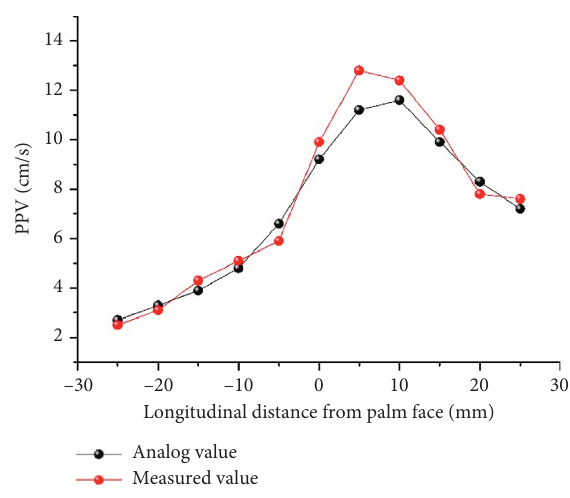
Figure 6: PPV from the right arch